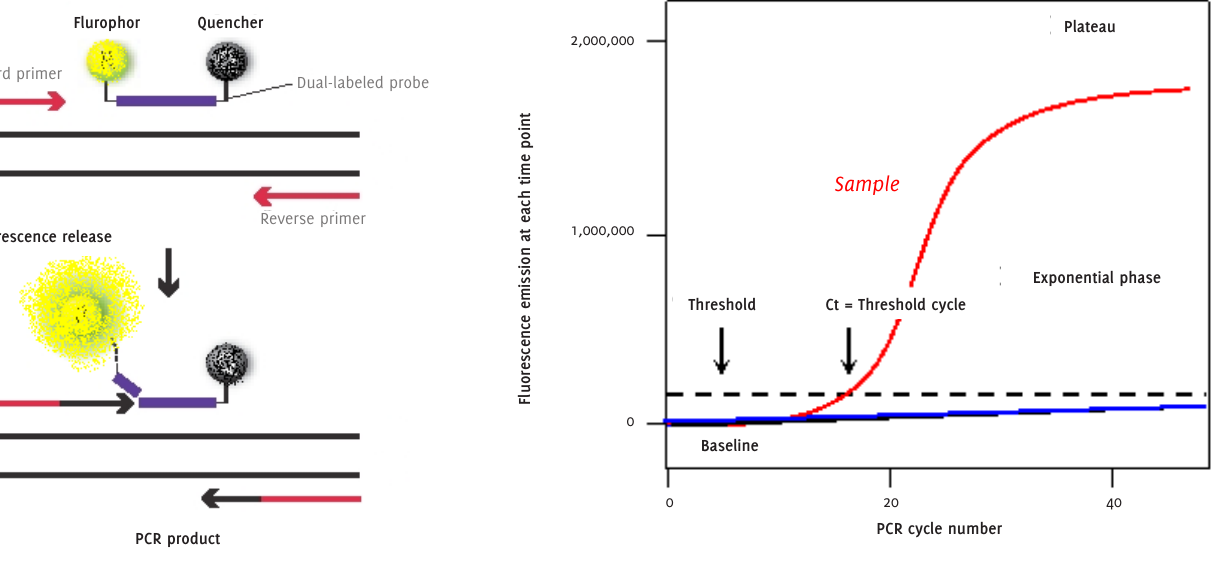
Figure 1. The principle of RT-PCR with dual labeled probe containing a Figure 2. Graphic representation of RT-PCR quantitative plot after 40 cycles, quantitative information of the flurophor on one end and a quencher molecule on the other. PCR process is obtained by plotting the intensity of the fluorescence signal versus cycle